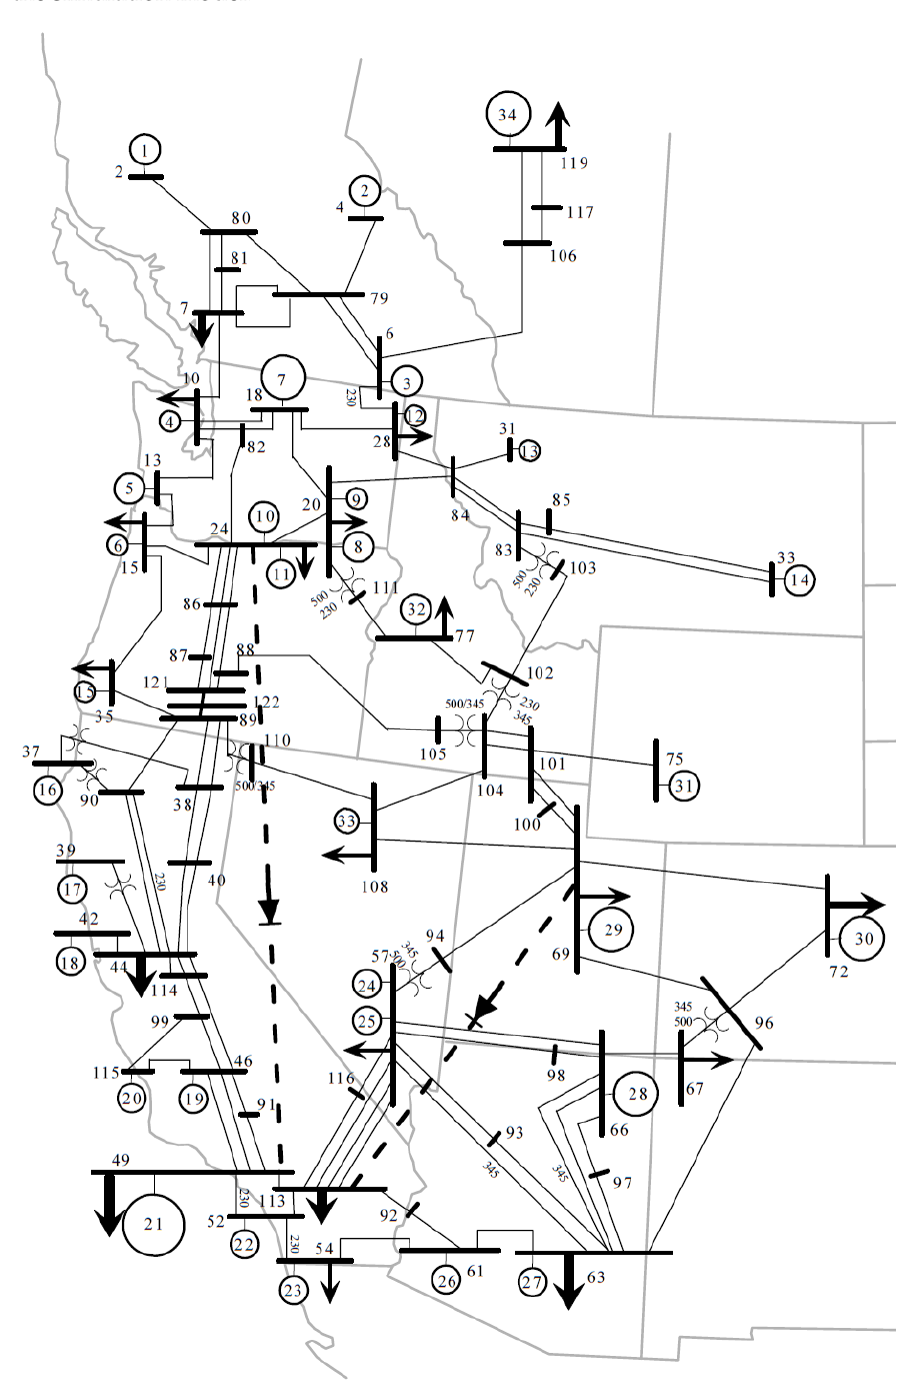
Figure 16. Reduced-order model of the WNAPS.